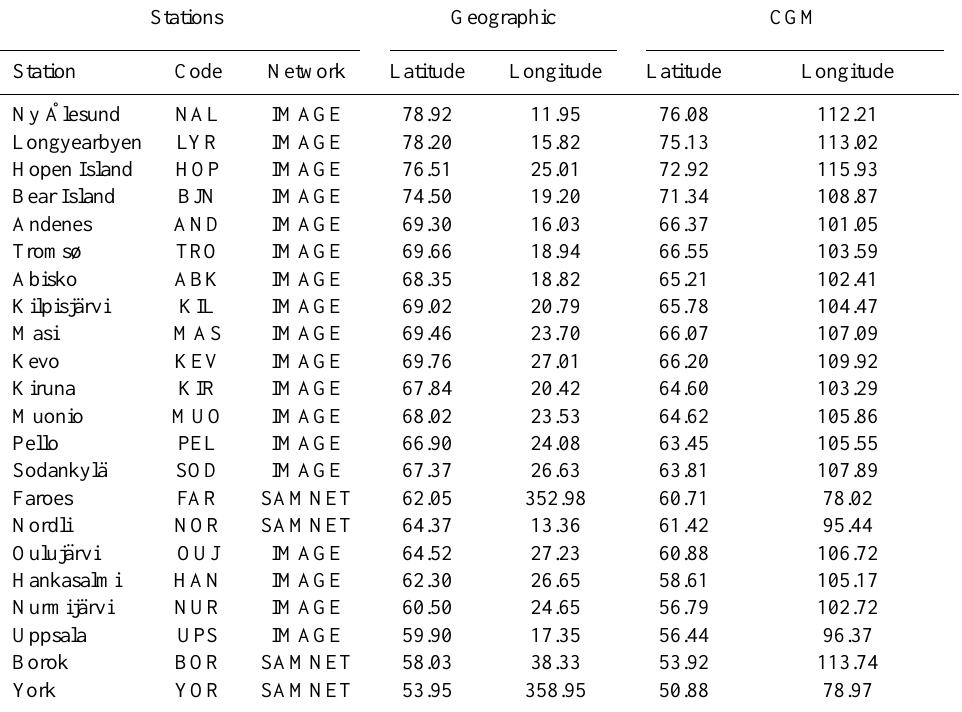
Table 2. The coordinates of the IMAGE and SAMNET magnetometer stations used in this study. The corrected geomagnetic coordinates (CGM) were calculated for the 2000 epoch at an altitude of 120km using the International Geomagnetic Reference Field converter at